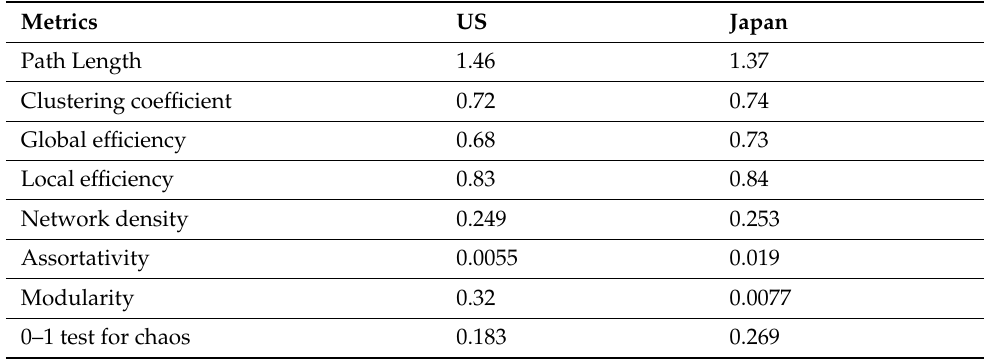
Table 2. Values of graph theory metrics obtained for both analyzed PDND networks.